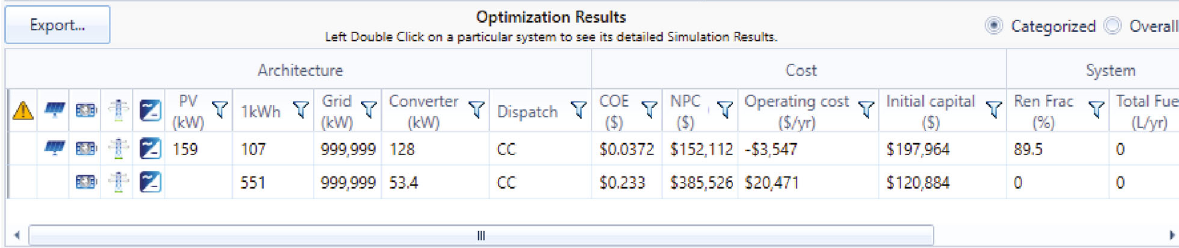
Figure 6: Optimization results for the proposed system.